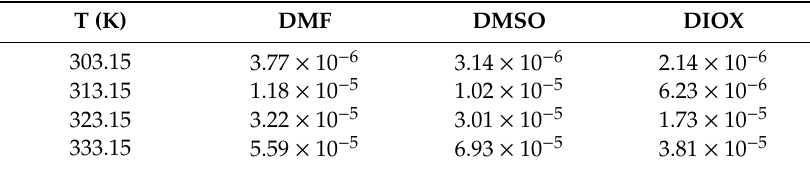
Table 6. AZO2 k r (in s − 1 ) constants in different solvents at different temperatures.